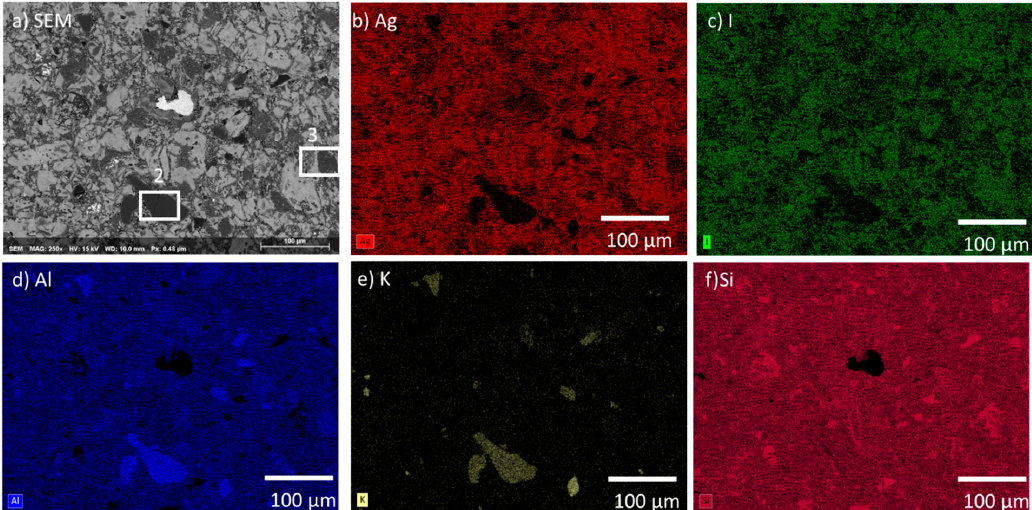
Figure 3. Microstructure of the AgZ 1-7 sample shown by: ( a ) SEM micrograph; and the corresponding EDS maps of: ( b ) Ag; ( c ) I; ( d ) Al; ( e ) K; and ( f ) Si. The large white inclusion in ( a ) is comprised of Fe and Mn whose sources are not known. The white boxes marked “2 and 3” are the locations where an EDS spot analysis was performed and listed in Table 3.